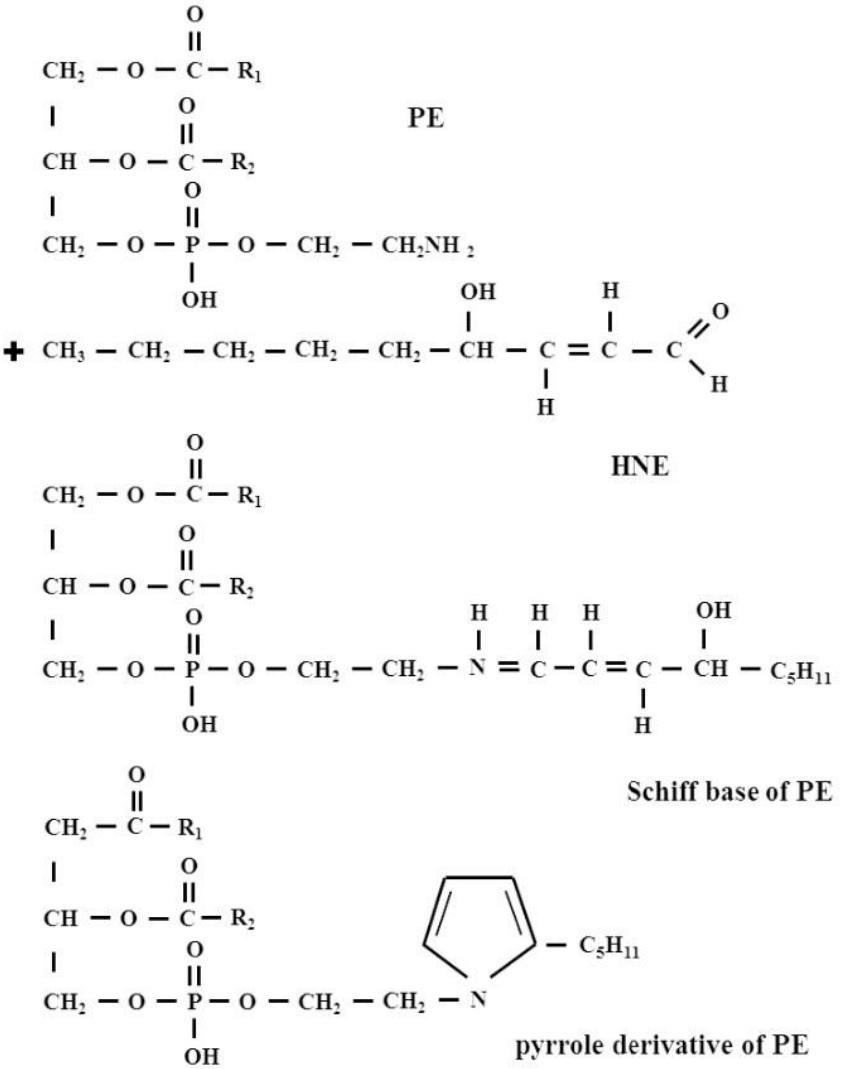
Figure 5. The formation of HNE-PE adducts: a Michael adduct and Schiff base adduct and also Schiff base adduct, which cyclizes as a pyrrole derivative via a loss of water.